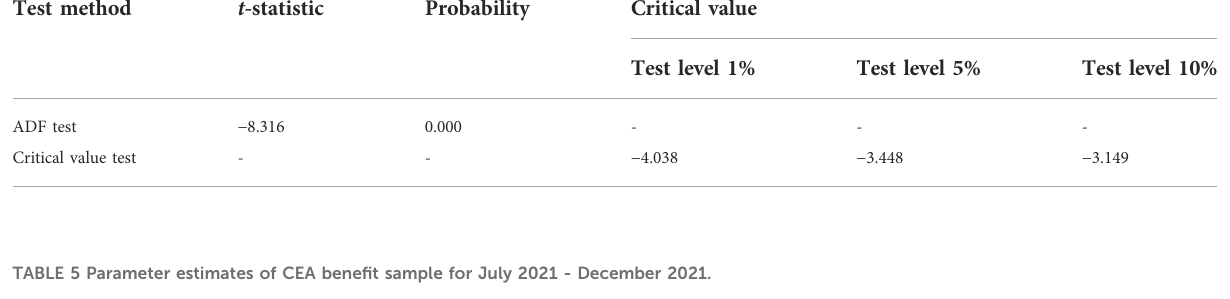
TABLE 4 ADF test of CEA bene fi t.